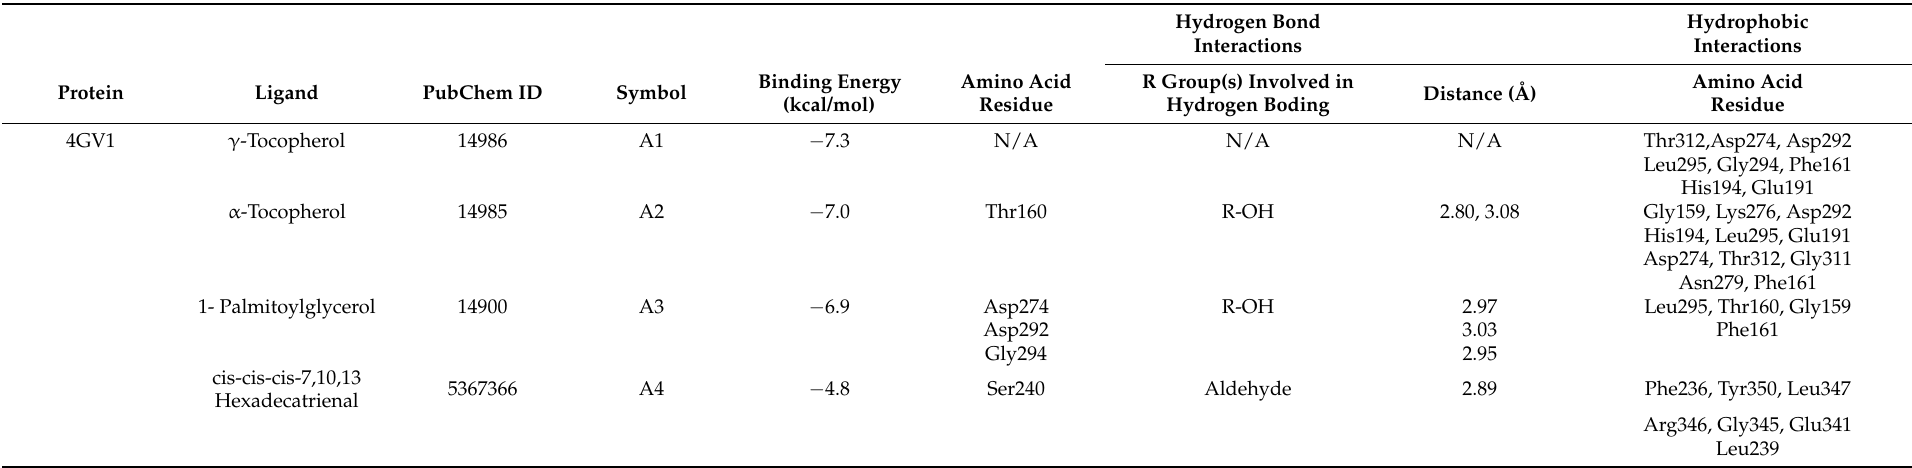
Table 5. Binding energy and interactions of potential bioactives on AKT1 (PDB ID: 4GV1).